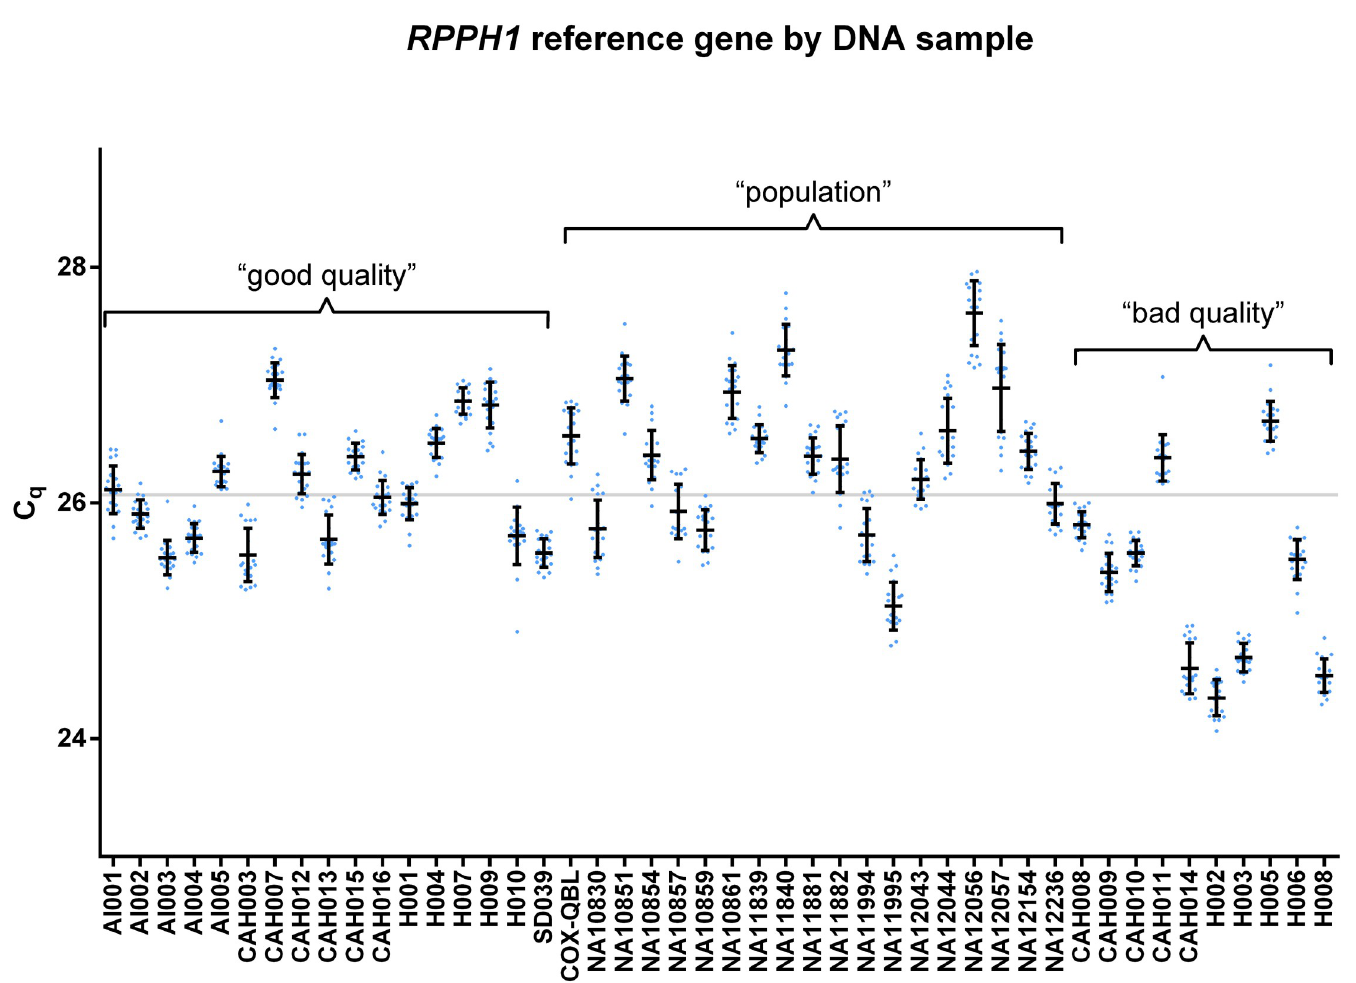
Fig 1. C q values (N = 966) of the RPPH1 reference gene grouped by DNA samples. The measurements of only one, predefined DNA working solution were taken into account for a calibration curve or a positive control DNA sample. A light blue dot indicates one RPPH1 Cq value. Means and standard deviations are indicated by bars. The mean of RPPH1 C q (26.0724) is indicated by a horizontal grey